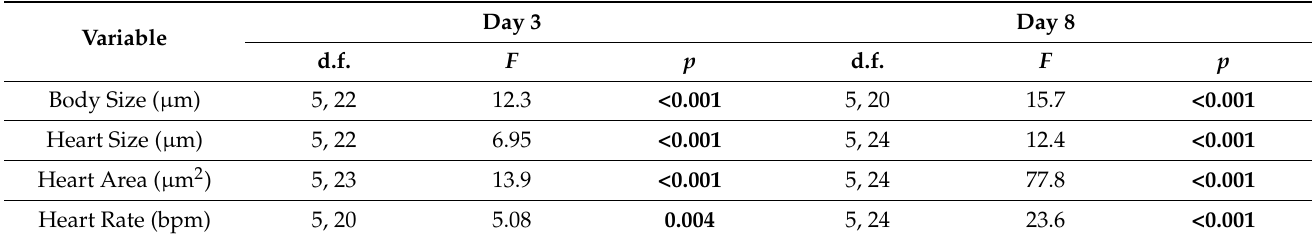
Table 3. Morphophysiological effects (body size, heart size, heart area, and heart rate) on Daphnia